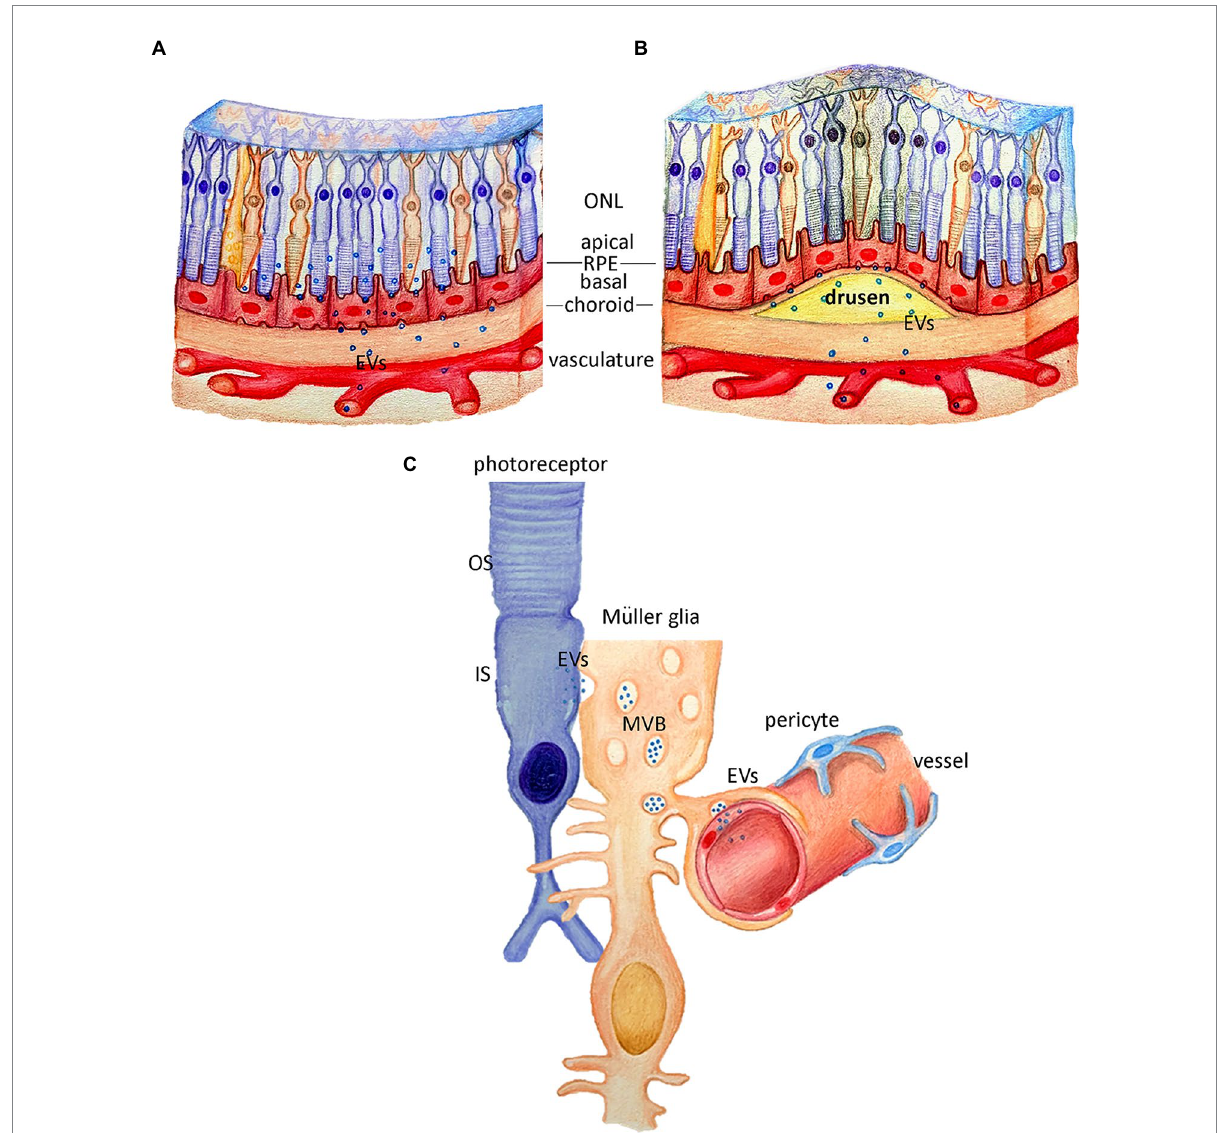
FIGURE 3 Potential roles of extracellular vesicles in retina pigment epithelium and Müller Glia cells. (A) Schematic representation of the retina, where retina pigment epithelium (RPE) is potentially releasing extracellular vesicles (EVs) from the apical and basal side under healthy conditions. (B) Schematic representation of the retina with drusen formation, where the RPE EV release from the basal side, may potentially contribute to the drusen pathology. (C) Schematic representation of the suggested roles of the EVs release by the Müller glia cells, either via MVB release of direct budding, under healthy conditions where the EVs can be released towards photoreceptors or towards the vascular